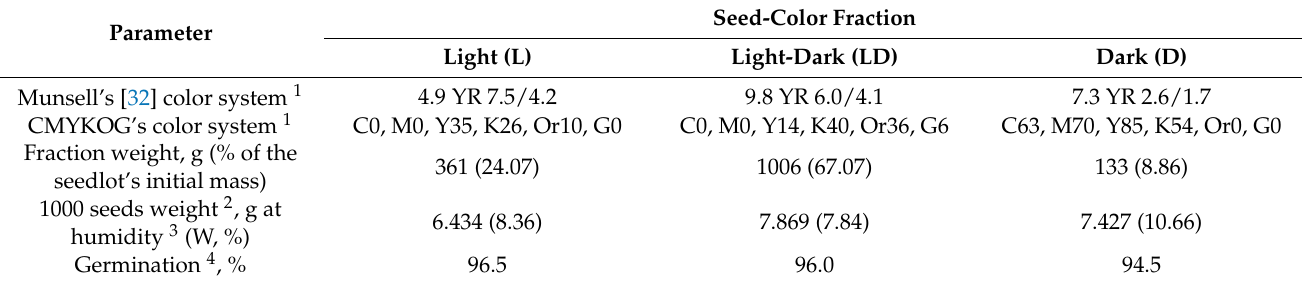
Table 1. Some physical and physiological features of Scots pine seedlot’s color fraction used in this study.